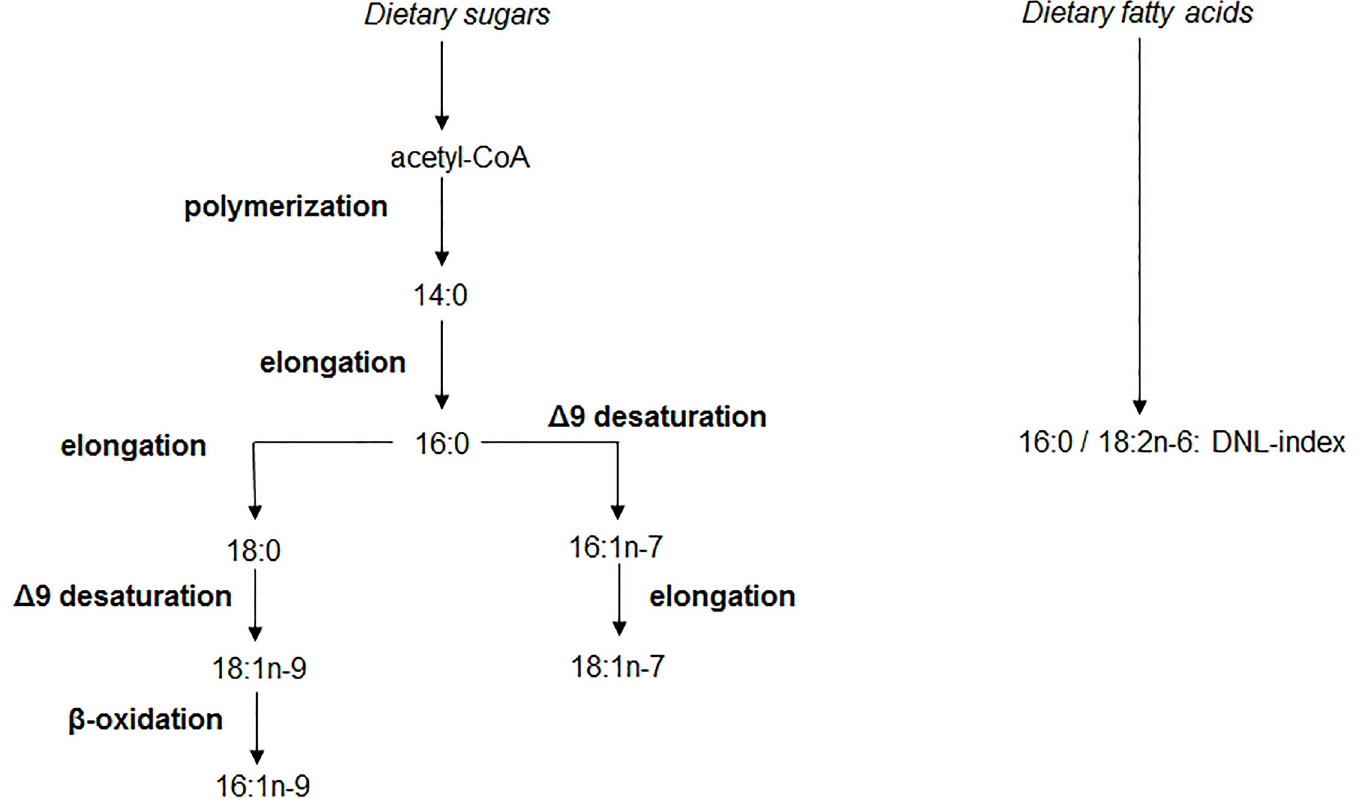
Fig 1. Major products of the DNL pathway. Acetyl-Coenzyme A (acetyl CoA) is polymerized to form FAs. The initial major product of DNL is palmitic acid (16:0) which can be transformed to palmitoleic acid (16:1n-7) by Δ 9 desaturation catalyzed by the Stearoyl-Coenzyme A desaturase and subsequently elongated to cis -vaccenic acid (18:1n-7) or elongated to stearic acid (18:0) and subsequently desaturated to oleic acid (18:1n-9). Myristic acid (14:0) is another possible minor product of FA synthesis. Experimental studies found that 7-hexadecanoic acid (16:1n-9) could be derived from the β -oxidation of 18:1n-9 [21]. The DNL-index is the ratio of the endogenously produced palmitic acid (16:0), the main product of DNL, and the essential FA linoleic acid (18:2n-6) whose origin is from dietary lipids. The DNL-index has been proposed as a tool to assess FA synthesis in humans [19,20].